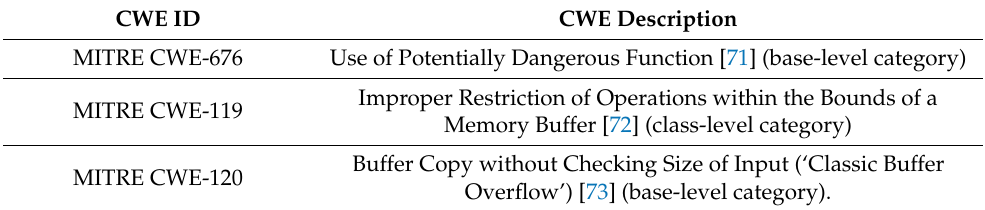
Table 3. MITRE CWEs related to Buffer